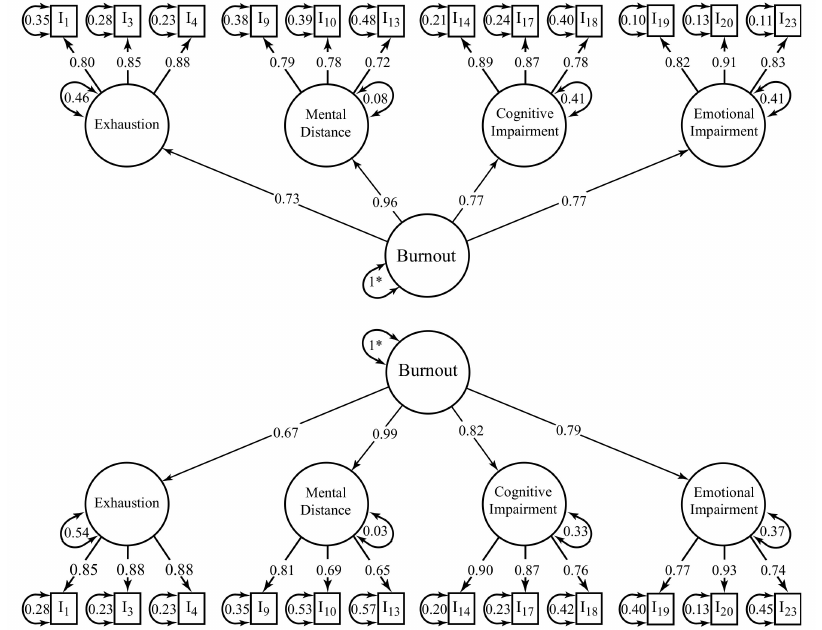
Figure 2. BAT-12’s factor loadings ( λ ) and structural weights ( γ ) for Brazil ( top ) and Portugal ( bottom ). * Indicates a fixed parameter. All paths were statistically significant ( p <